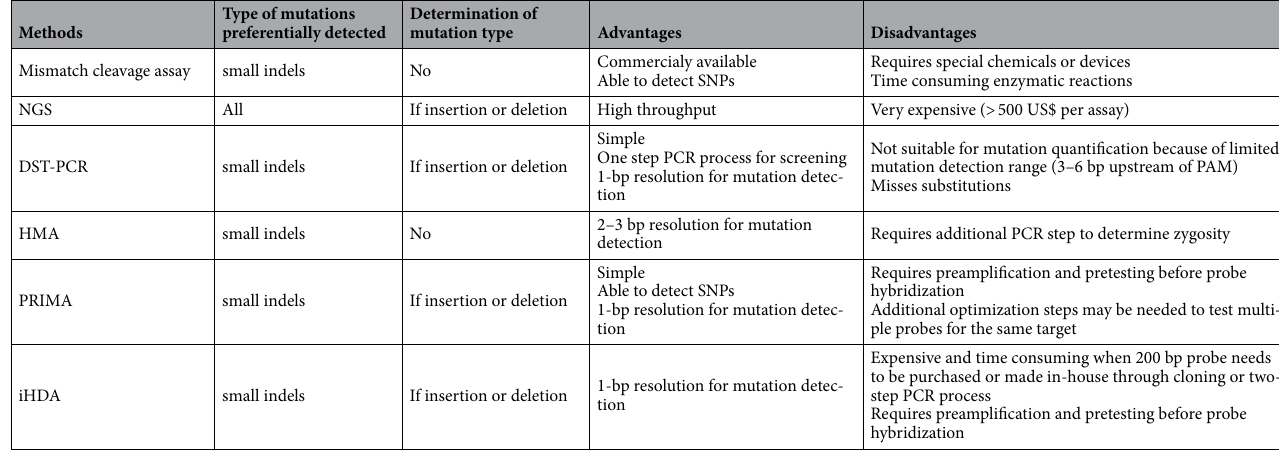
Table 3. Comparison of DST-PCR with other